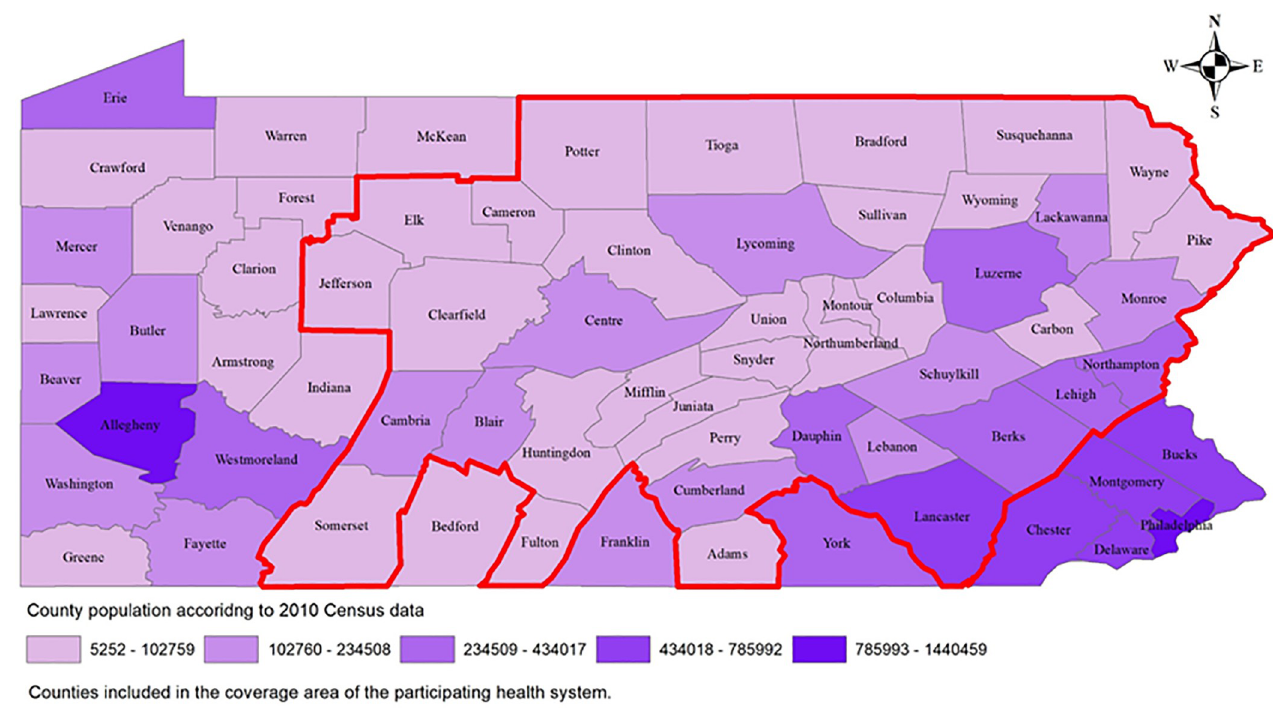
Fig 1. Geisinger Health System Coverage Area,